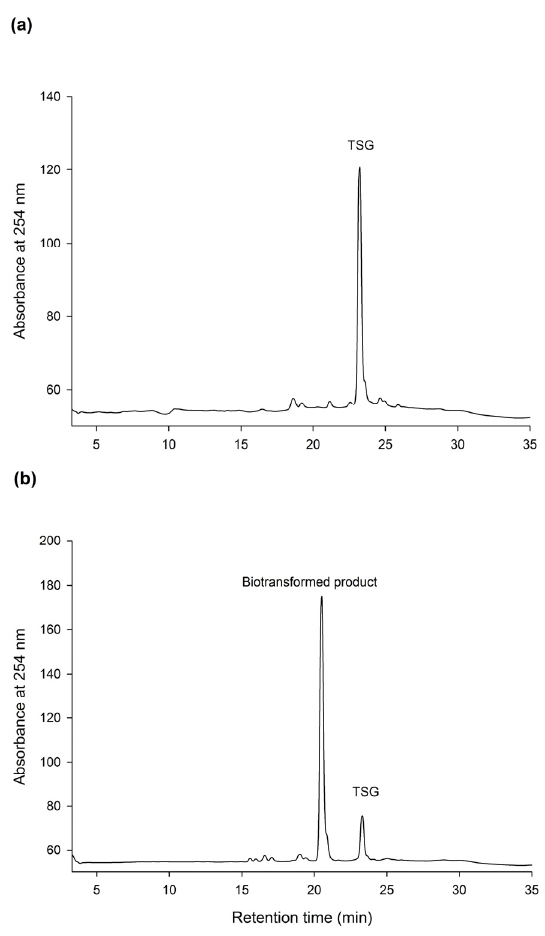
Figure 4. HPLC analysis of 3,5,4 ′ -trihydroxystilbene-2- O - β -glucoside (TSG) ( a ) and the biotrans- formed product by using Bm TYR ( b ). The biotransformation and HPLC conditions were the same as those in the legend of Figure 1, with the replacement of the enzyme substrate (2 mg/mL of Ha-Soo-Oh crude extract) with a TSG standard (2 mg/mL). The retention times of TSG in and the biotransformed product are 22.3 and 20.5 min, respectively.